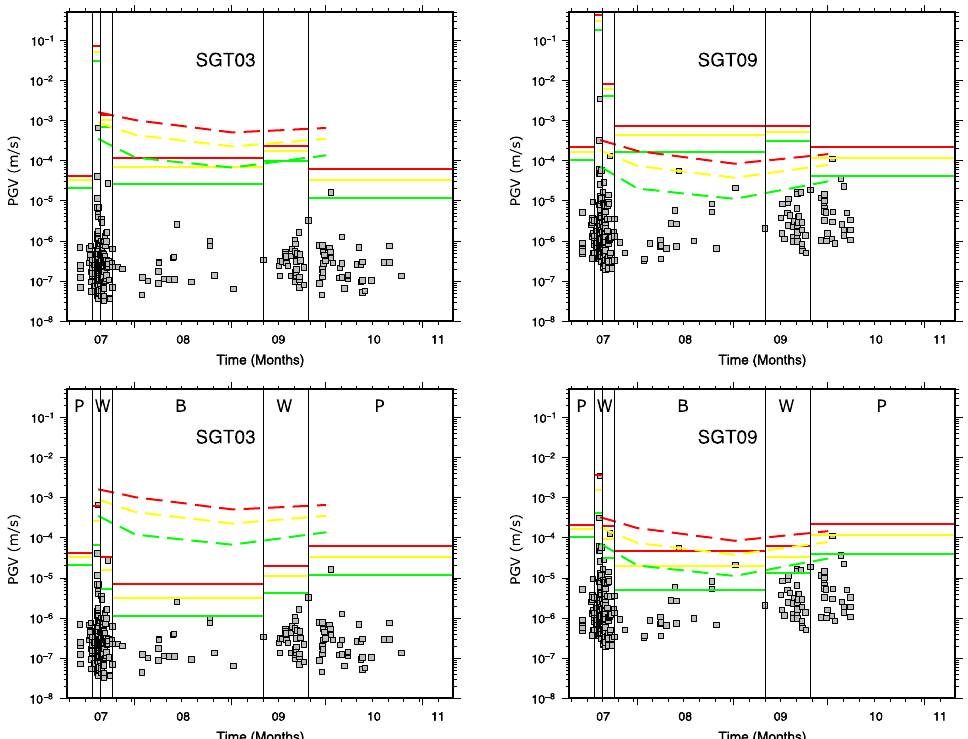
Figure 7. Hazard analysis for three probability of exceedance (10% (red line), 20% (yellow) and 50% (green)) and a 0.5 month exposure time. The same color code is used for the ETAS model, but with dashed lines. The time period is reported in Table 1. Upper panels refer to time independent analysis while lower panels refer to the time dependent analysis. Letters in the lower panels indicate the best PDF for each period (P: Poisson; W: Weibull; B: Brownian Passage Time) (See Table 1). Grey squares represent the observed PGVs at the two stations indicated in the two